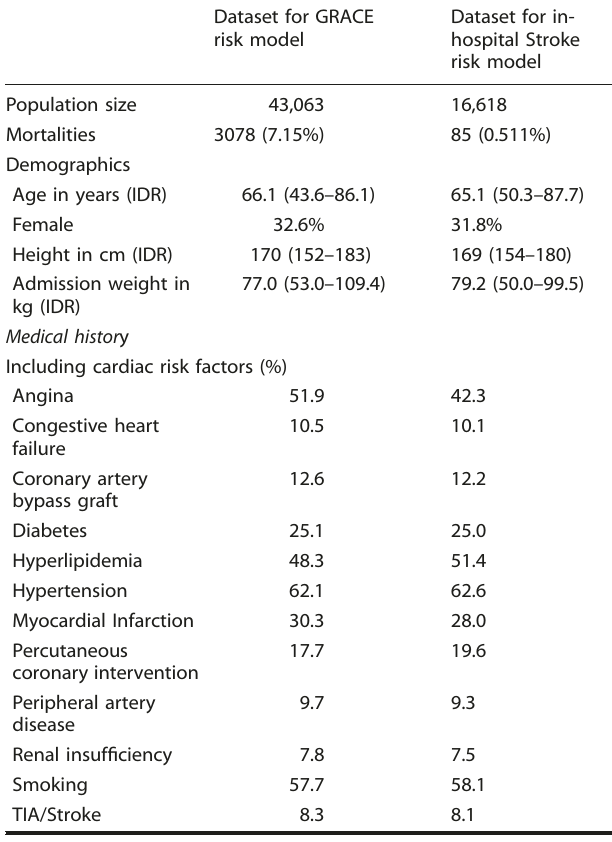
Table 1. Population characteristics in the subset of the GRACE dataset used for all